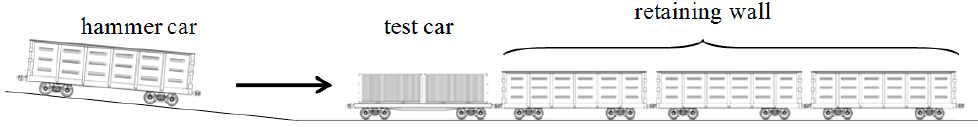
Figure 13. Scheme of car collision.